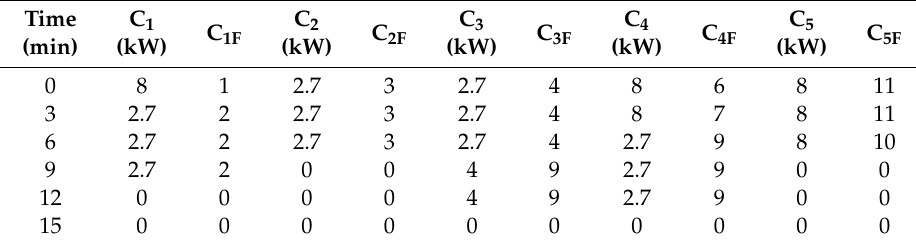
Figure 13 allows the results to be compared for the same time